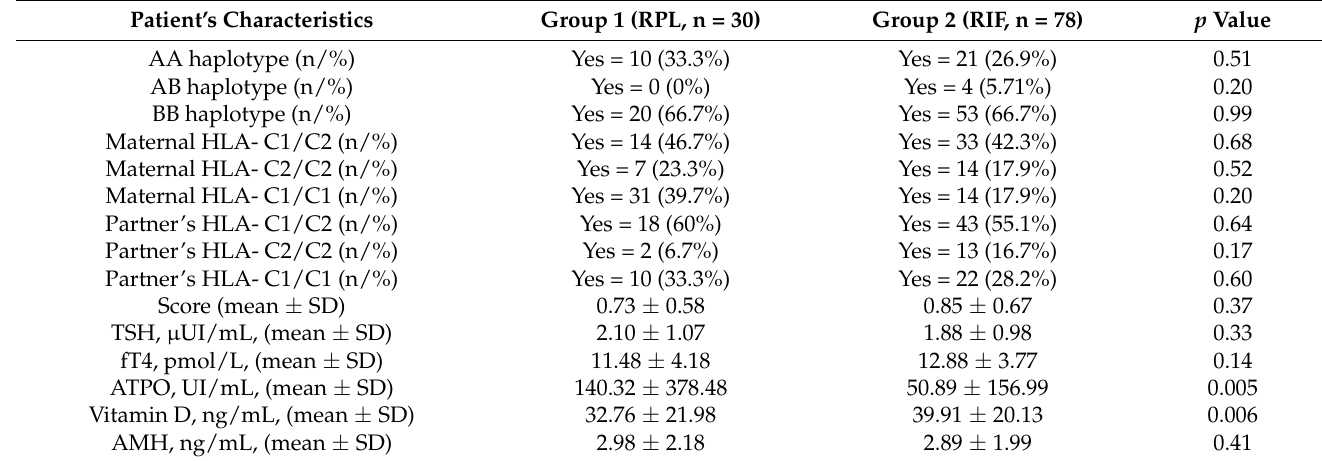
Table 2. Paraclinical characteristics of the patients included in the main